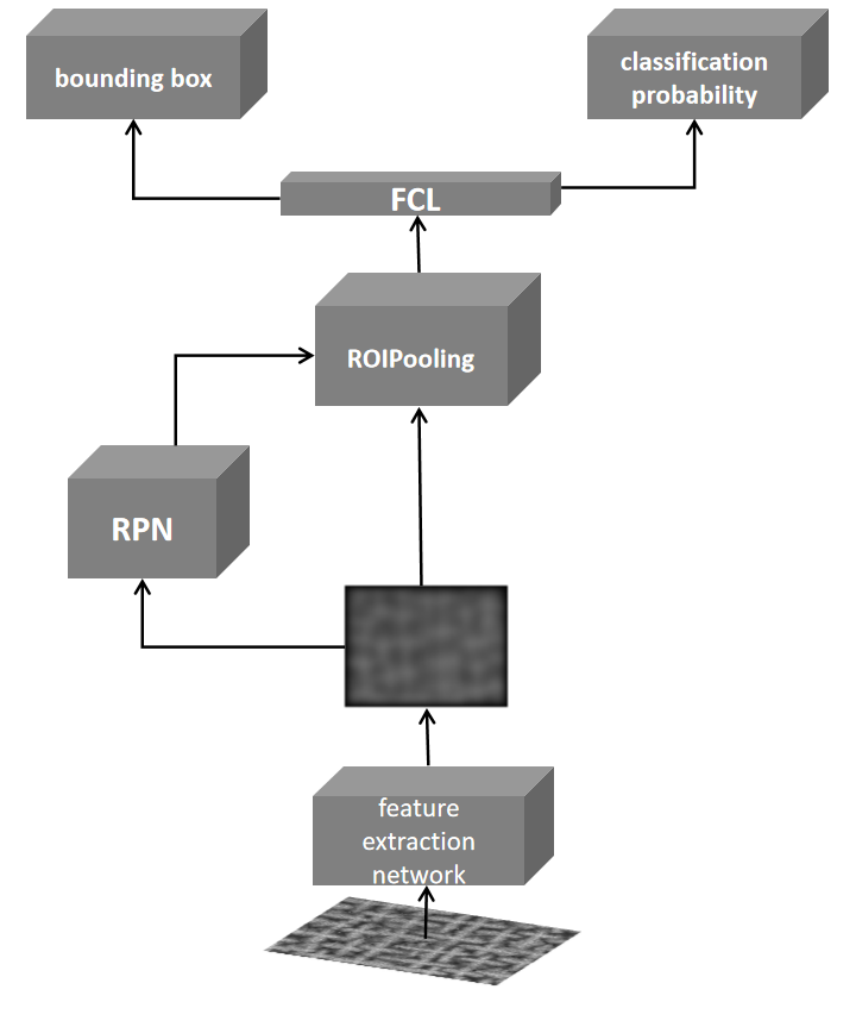
Figure 3. Architecture of Faster R-CNN: FCL represents fully connected layers and RPN represents the region proposal network.